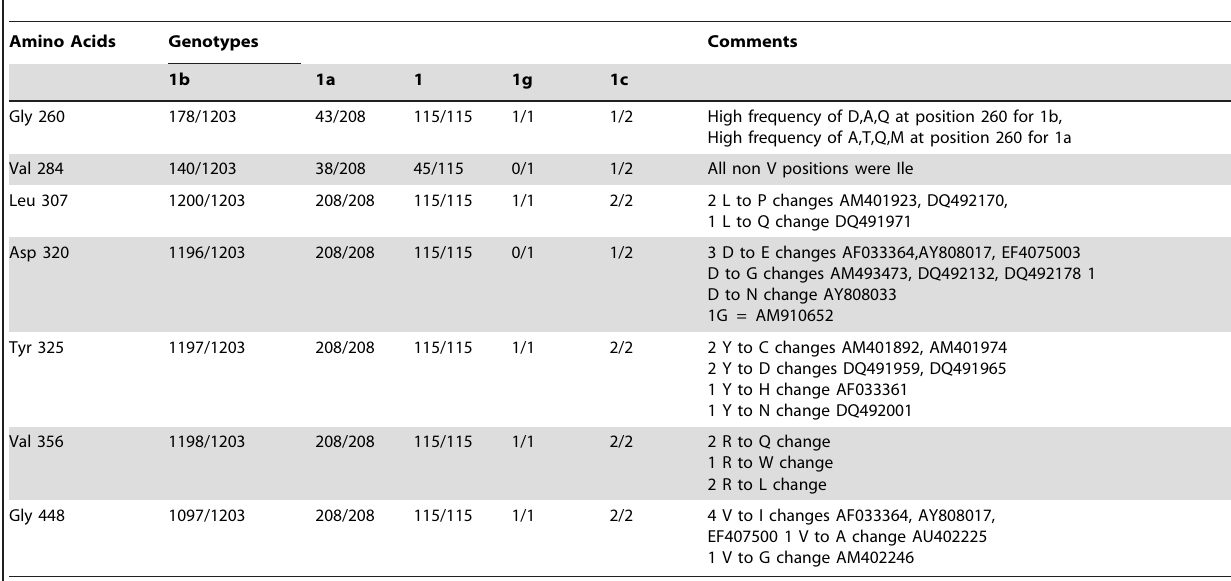
Table 1. Conservation of amino acids at positions identified by 3s mutant in HCV sequenced from genotype 1 patients.